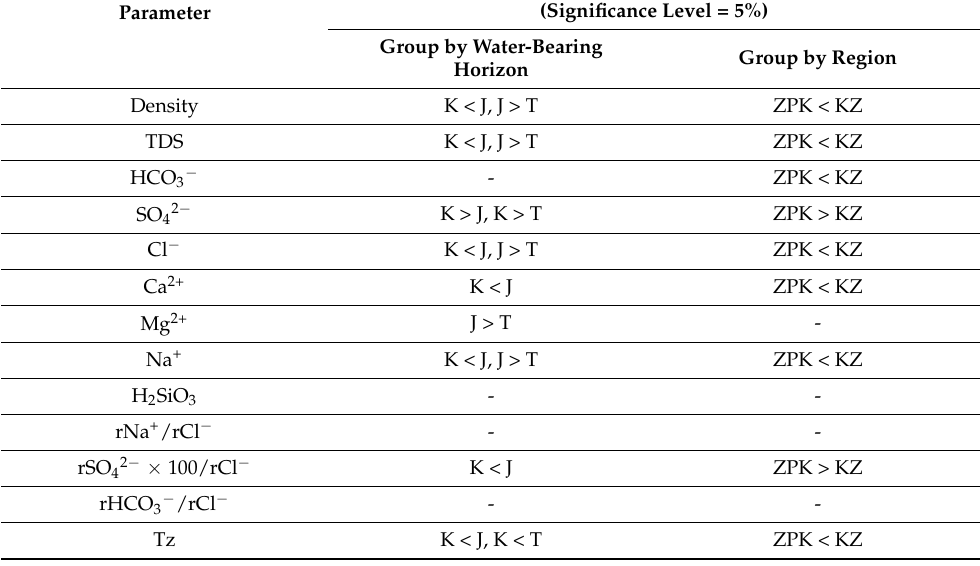
Table 3. Conclusions taken from the Kruskal–Wallis test, Duncan test, and boxplots of statistically significant differences between distributions and mean values, grouped by the water-bearing horizon (K, J and T) and by region (ZPK,